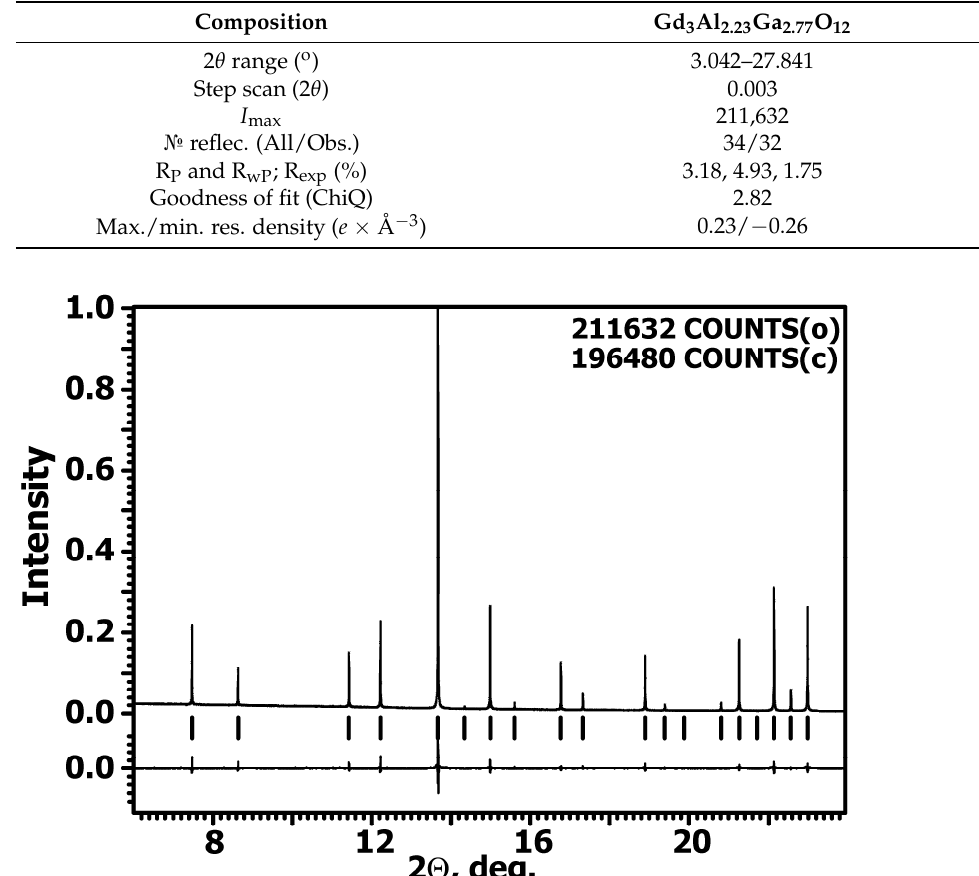
Figure 2. Fragments of the observed, calculated, and difference XRD patterns for Gd 3 Al 2.22 Ga 2.78 O 12 :Ce. Tick marks denote the peak positions of possible Bragg reflections. Table 1. Crystallographic data and refinement results for the Gd 3 Al 2.23 Ga 2.77 O 12 :Ce structure (SG Ia − 3 d , Z = 8).